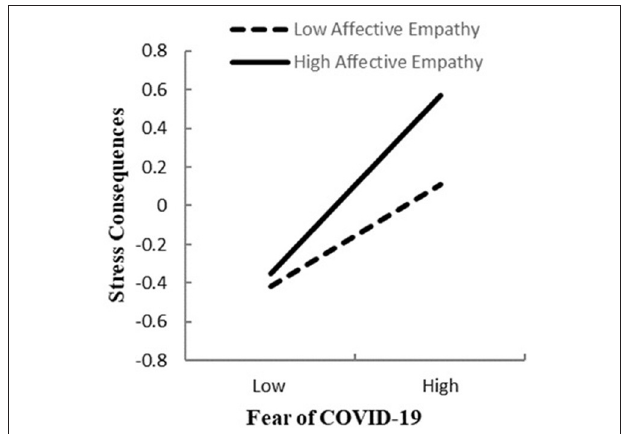
FIGURE 2 | Association between fear of COVID-19 and stress consequences at higher and lower levels of affective empathy.